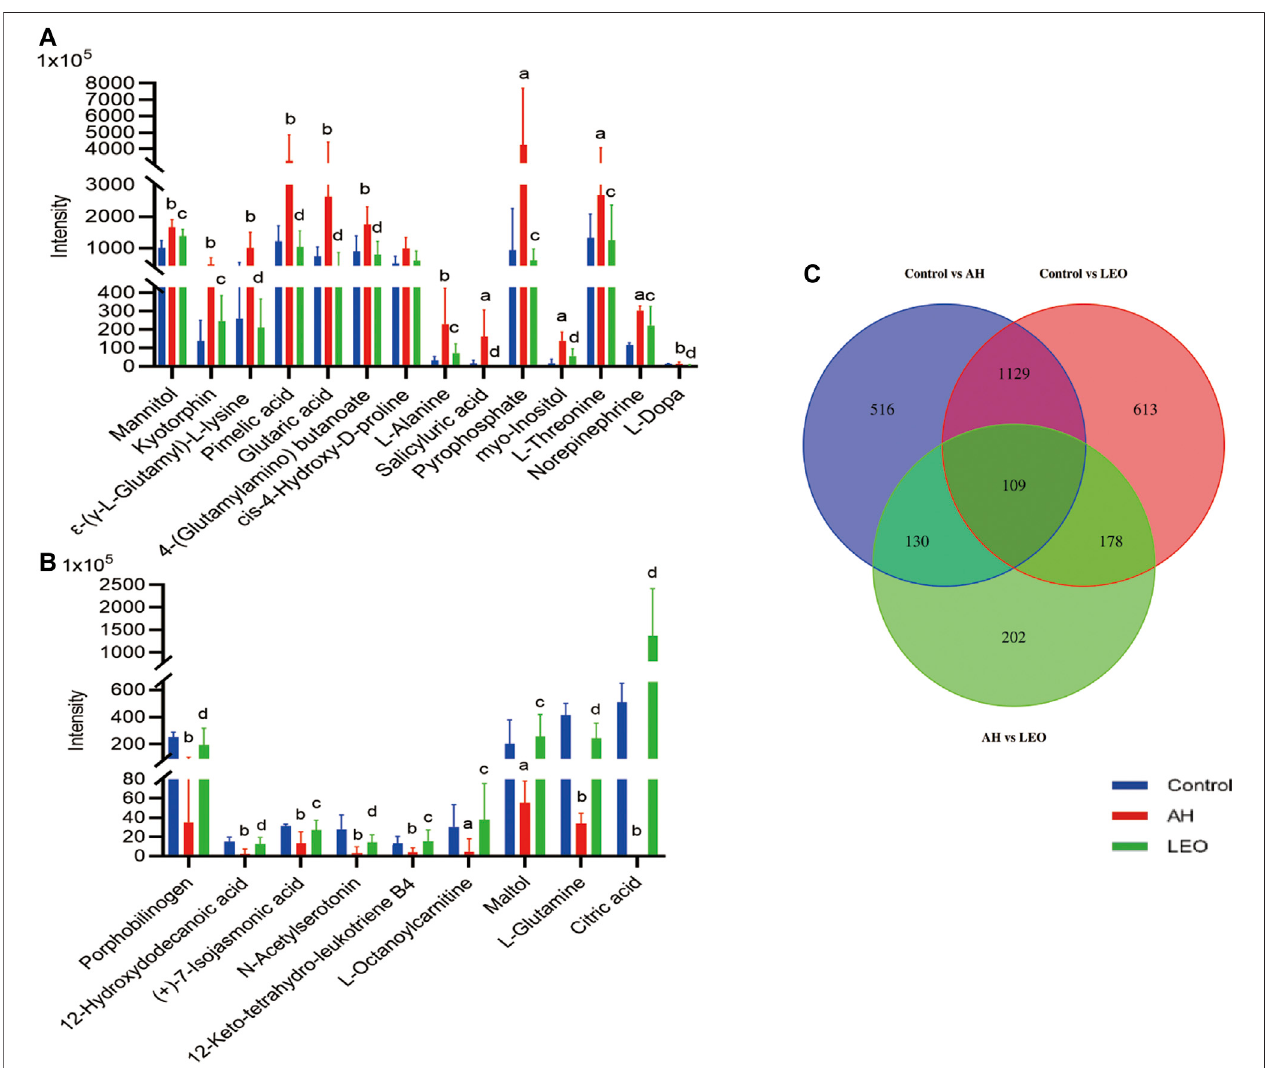
FIGURE 11 | The normalized intensity of differential metabolites in control, AH and LEO groups. (A) and (B) Relative intensities of the 23 important differential metabolites. (C) Venndiagramofprimarymetabolicdifferentialsbetweendifferentgroups.a p < 0.01 ,b p < 0.001 ,vscontrolgroup;c p < 0.01 ,d p < 0.001 ,vsAHgroup.